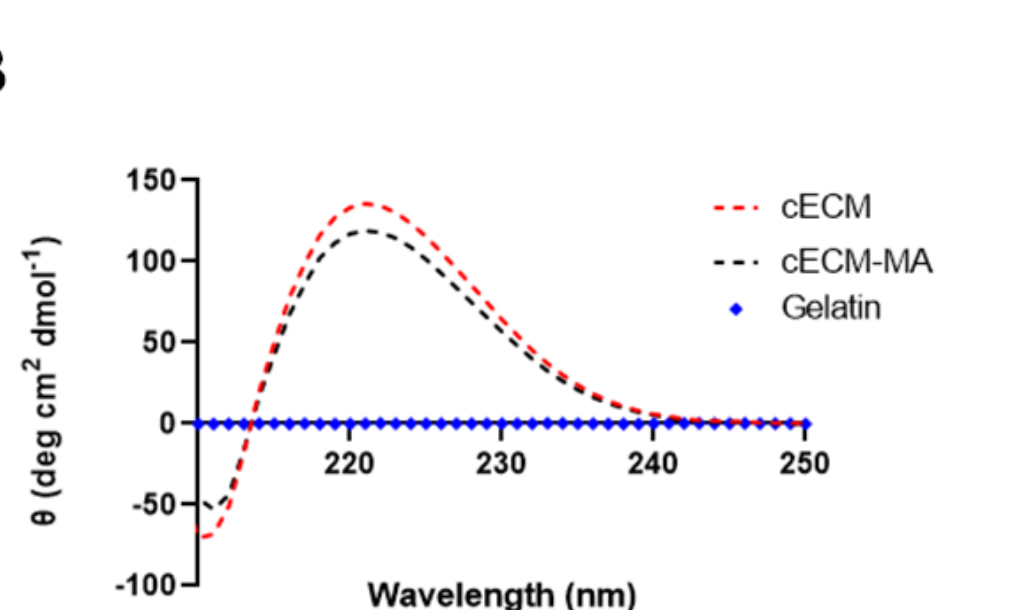
Figure 2. ( A ) 1 H-NMR spectra of cartilage ECM (cECM) and cartilage ECM methacryloyl (cECM- MA) recorded in CDCOOD (*) at room temperature. ( B ) CD spectra of cECM, cECM-MA, and gel- atin.